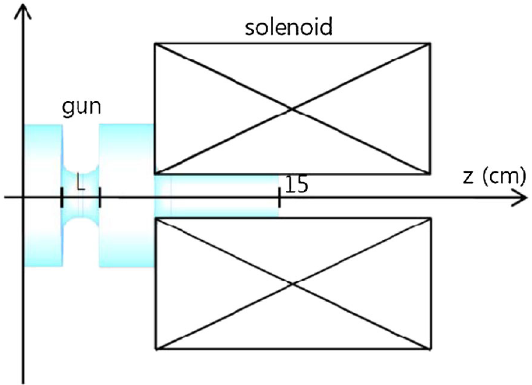
FIG. 5. Simulation layout. Gun and solenoid magnet.